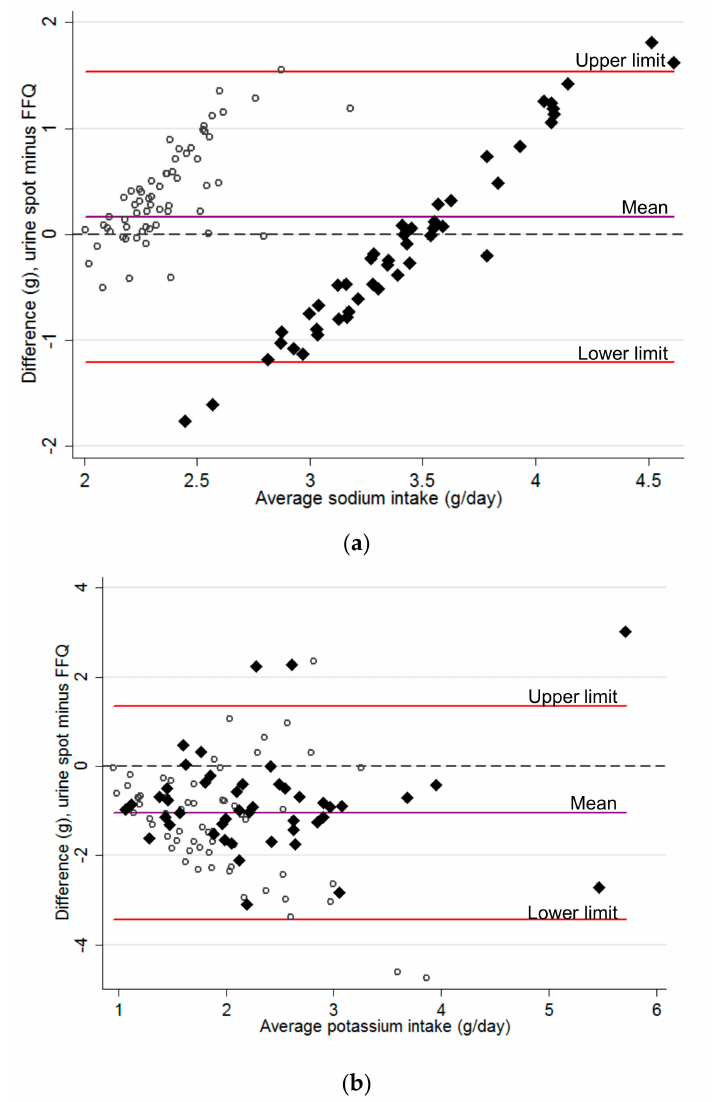
Figure 1. Bland–Altman plot of ( a ) average sodium and ( b ) potassium intake based on the intake calculated with a food frequency questionnaire 1 and a morning fasting spot urine in 111 childhood cancer survivors of the SCCSS-Nutrition study. FFQ—food frequency questionnaire; SCCSS—Swiss Childhood Cancer Survivor Study. Y = 0 is the line of perfect average agreement, the hollow circles ( represent females and the black diamonds ( (cid:7) ) represent males. 1 Sodium (Na) intake based on food frequency questionnaire (FFQ) data was calculated with the equation: (8.20 + 0.38 × FFQ in males) / 2.54 and (4.55 + 0.67 × FFQ in females) / 2.54, with 1 g Na = 2.54 g salt (NaCl) [25]. Na intake is clustered by sex due to this equation. Intake based on FFQ data only gives a mean daily intake of 1.9 g ±